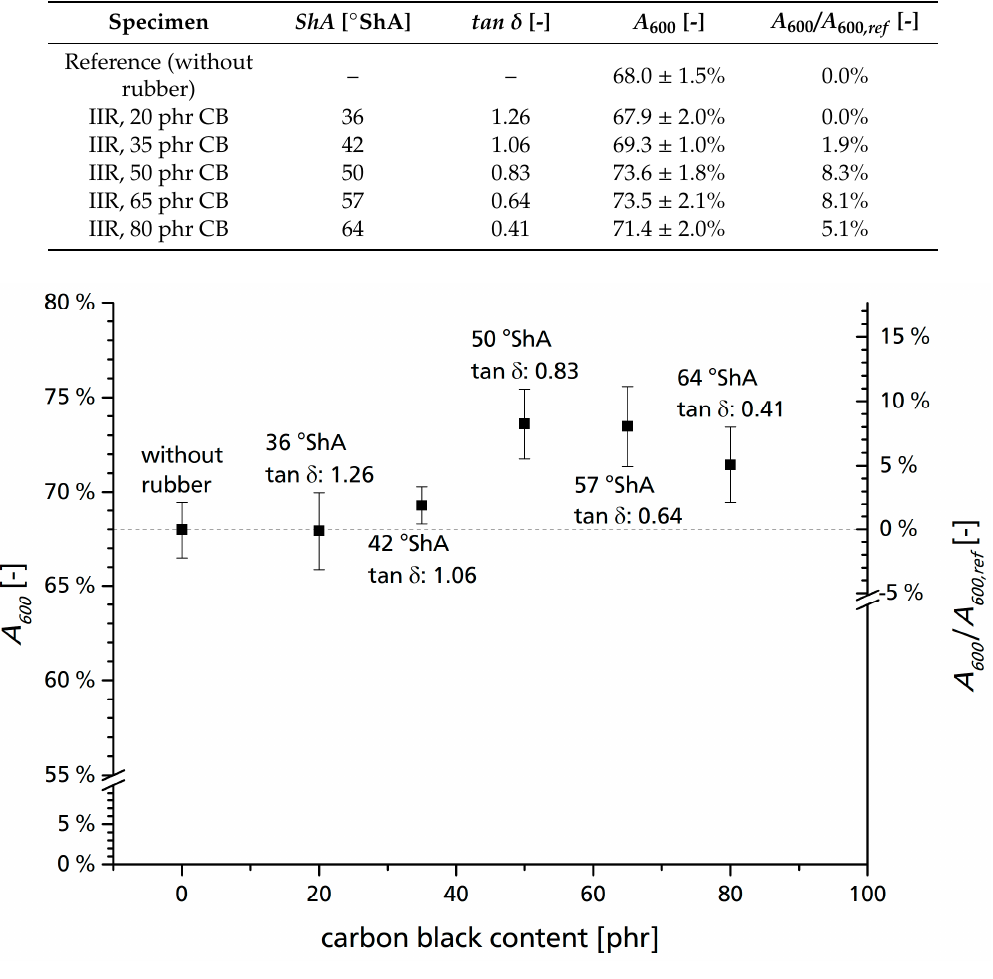
Figure 11. Energy absorption during ballistic impact experiments for configurations using IIR formulations with varying carbon black content.